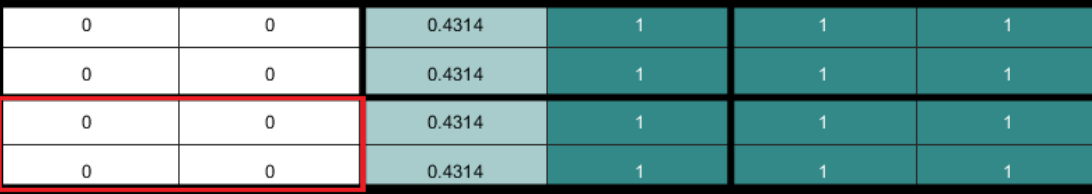
Figure 16. Subdivision for the grid Box G for the fourth obstacle.